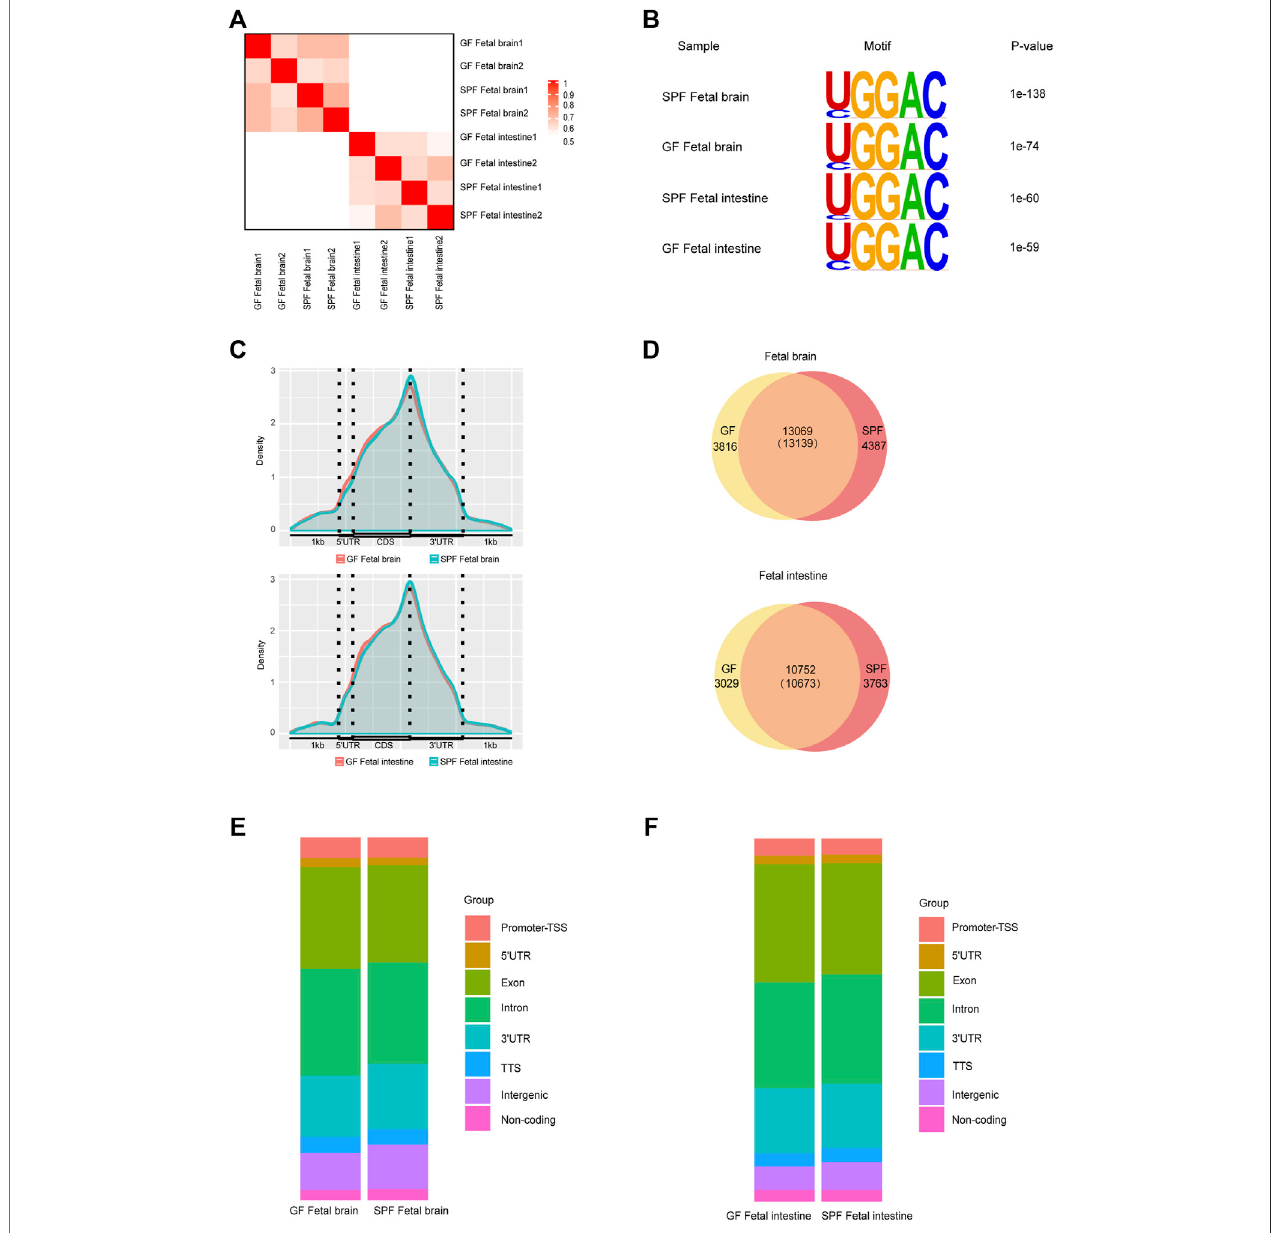
FIGURE 2 | Modi fi cation pro fi les of m 6 A in the fetal brain and intestine. (A) Similarity (using Pearson ’ s correlation) of m 6 A peaks between each pair of samples. (B) Motifanalysisofm 6 ApeaksinfetalbrainsandintestinesofSPFandGFmice. (C) Patterndistributionofm 6 AacrossthemRNAregionsinthefetalbrainandintestine.m 6 A peaksweremappedbacktothecorrespondinggenes,andassignedasoriginatingfromthe5 ′ -UTR,codingsequence(CDS),or3 ′ -UTR. (D) Venndiagramshowingthe overlap of m 6 A peaks between fetal brains and intestines of SPF and GF mice. (E,F) Bar charts showing the distribution of m 6 A peaks in the fetal brain (E) and intestine (F)